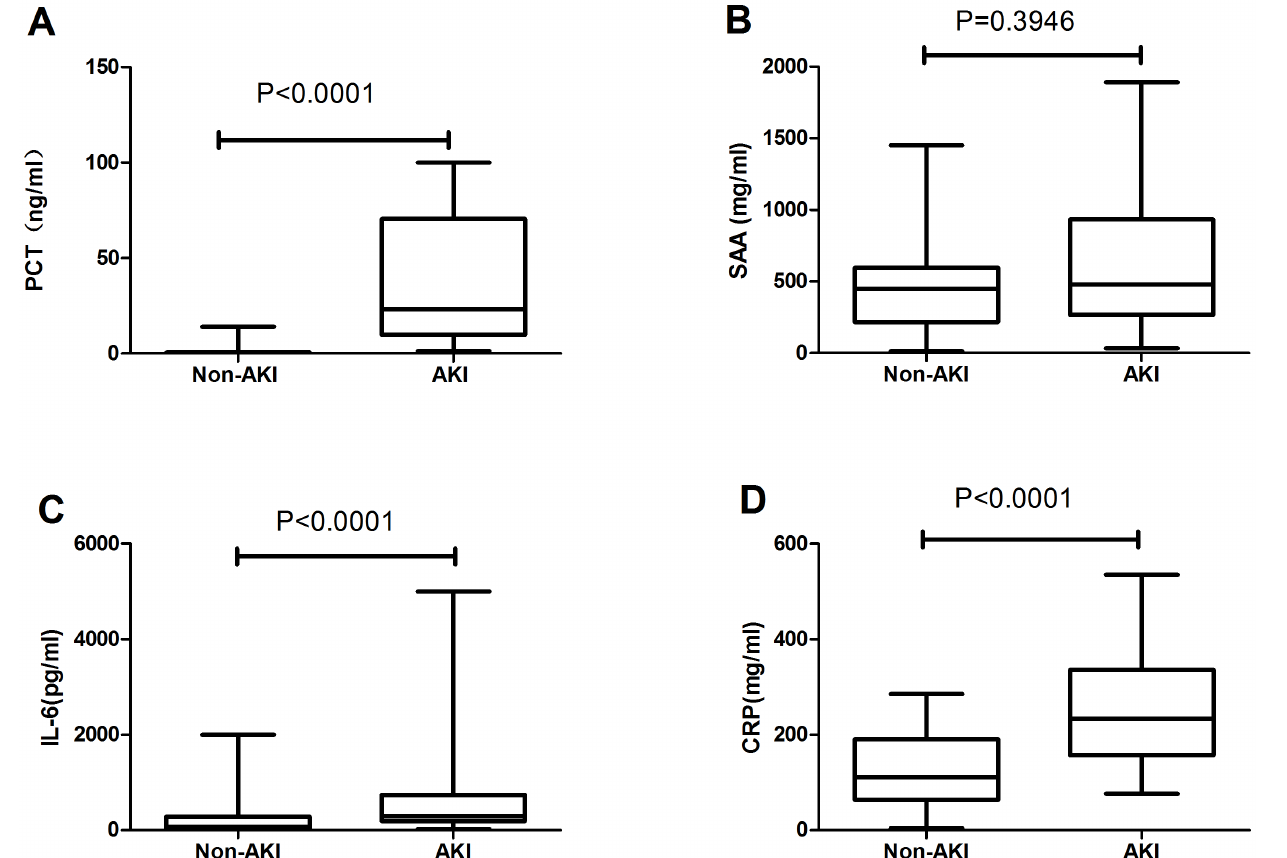
Figure 1. Initial levels of infection markers in non-AKI and AKI patients. The boxes indicate the interquartile range (IQR). The dark lines denote the median. The whiskers portray minimum and maximum values. Levels in the two groups were compared using the Wilcoxon rank sum test.